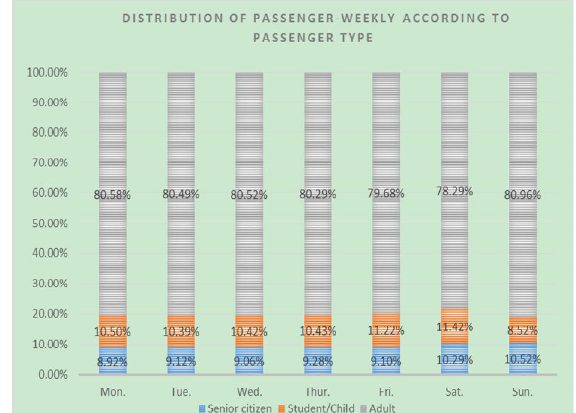
Figure 1. The proportion of travel records corresponding to the three categories for the whole week, in March 2012.